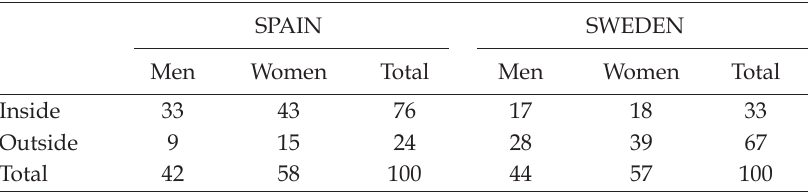
Table 5. Distribution of all hours of caregiving, inside and outside, respectively, of one’s household, Spain and Sweden, 2014 Per cent